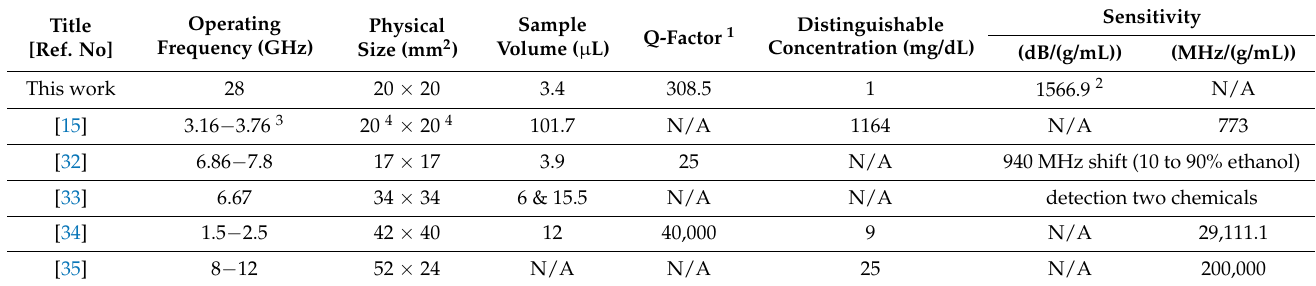
Table 1. Comparison with sensors using spoof SP or